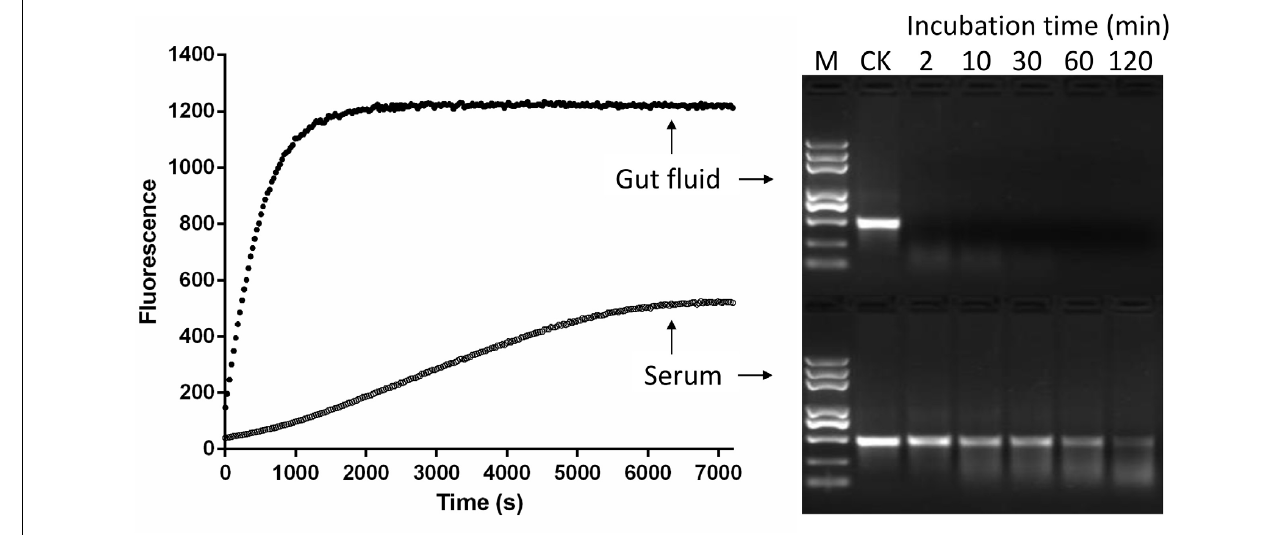
FIGURE 3 | Comparison of fluorescent (Left) and gel electrophoresis (Right) methods for analyzing dsRNA degrading nucleases in S. litura serum and gut fluid. Both serum and gut fluid were diluted 20 times with nuclease free water, and the fluorescence reaction was incubated with 24 bp fluorescence labeled dsEGFP in the final concentration 0.5 µ M. The gel electrophoresis reaction was incubated with 414 bp naked dsEGFP in the final concentration 0.05 µ g/ µ L. CK: Control without enzymes. M: Trans 2K Plus DNA marker. Numbers 2–120 were the minutes indicating sample incubation time.